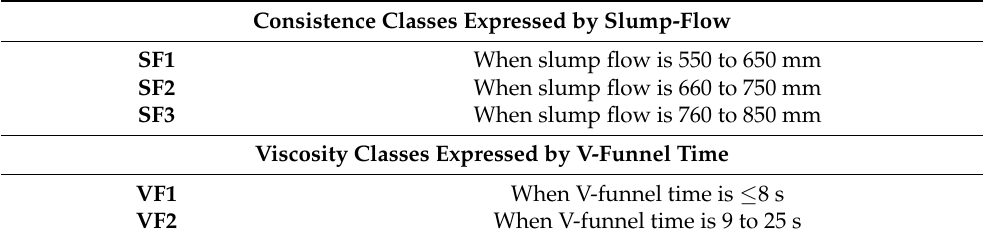
Table 4. Classes of consistency and viscosity of